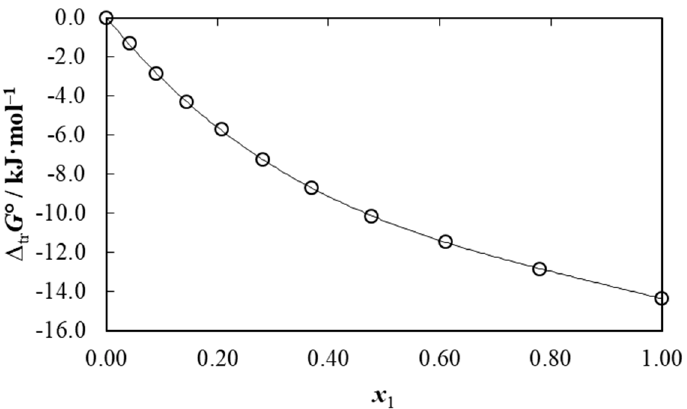
Figure 5. Gibbs energy of transfer of benzoic acid (3) from neat water (2) to {ethanol (1) + water (2)} mixtures at T = 298.15 K.